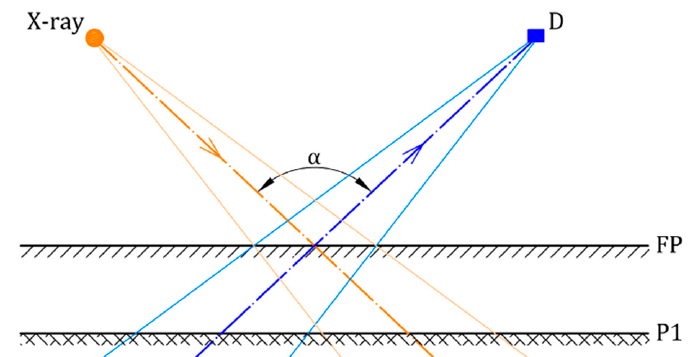
Figure 2. General scheme of the XRF analysis technique.